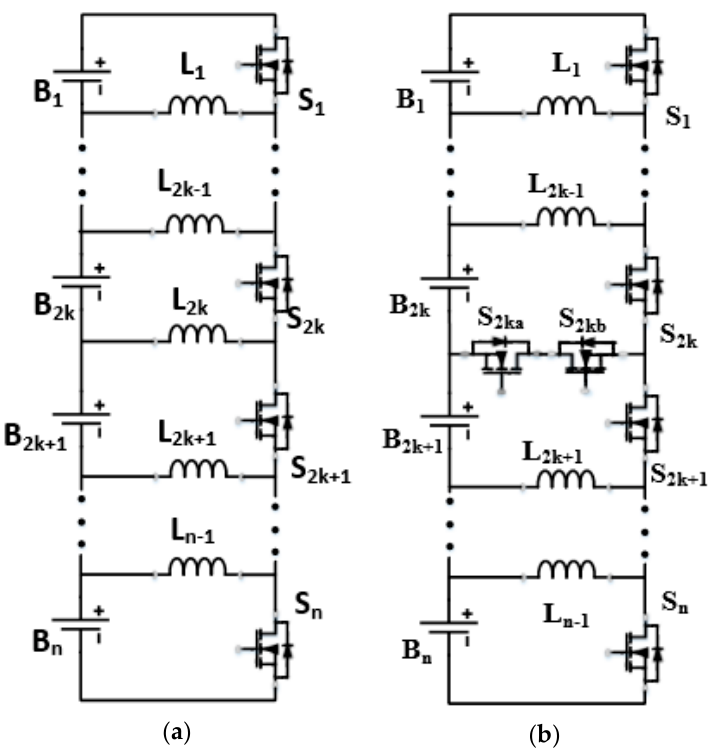
Figure 3. Structure of equalizer. ( a ) The multiple switch-inductors equalizer (MSIE). ( b ) The novel inductor-based non-dissipative equalizer (NIBNDE).